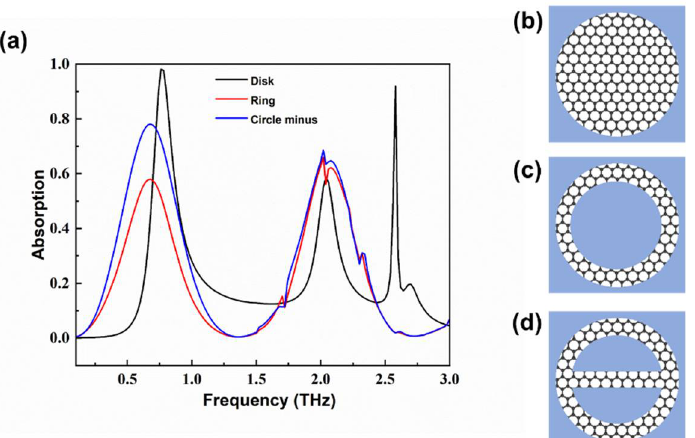
Figure 2. Preparation of graphene film and the proposed absorber based patterned graphene met- amaterials.